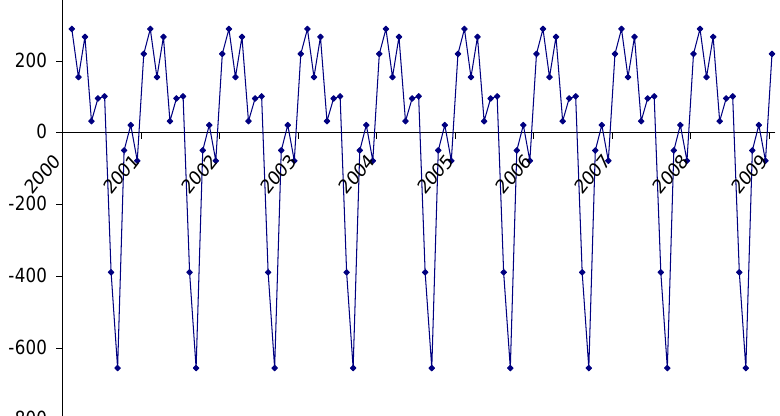
Figure 1 Model 1 - Seasonal Component